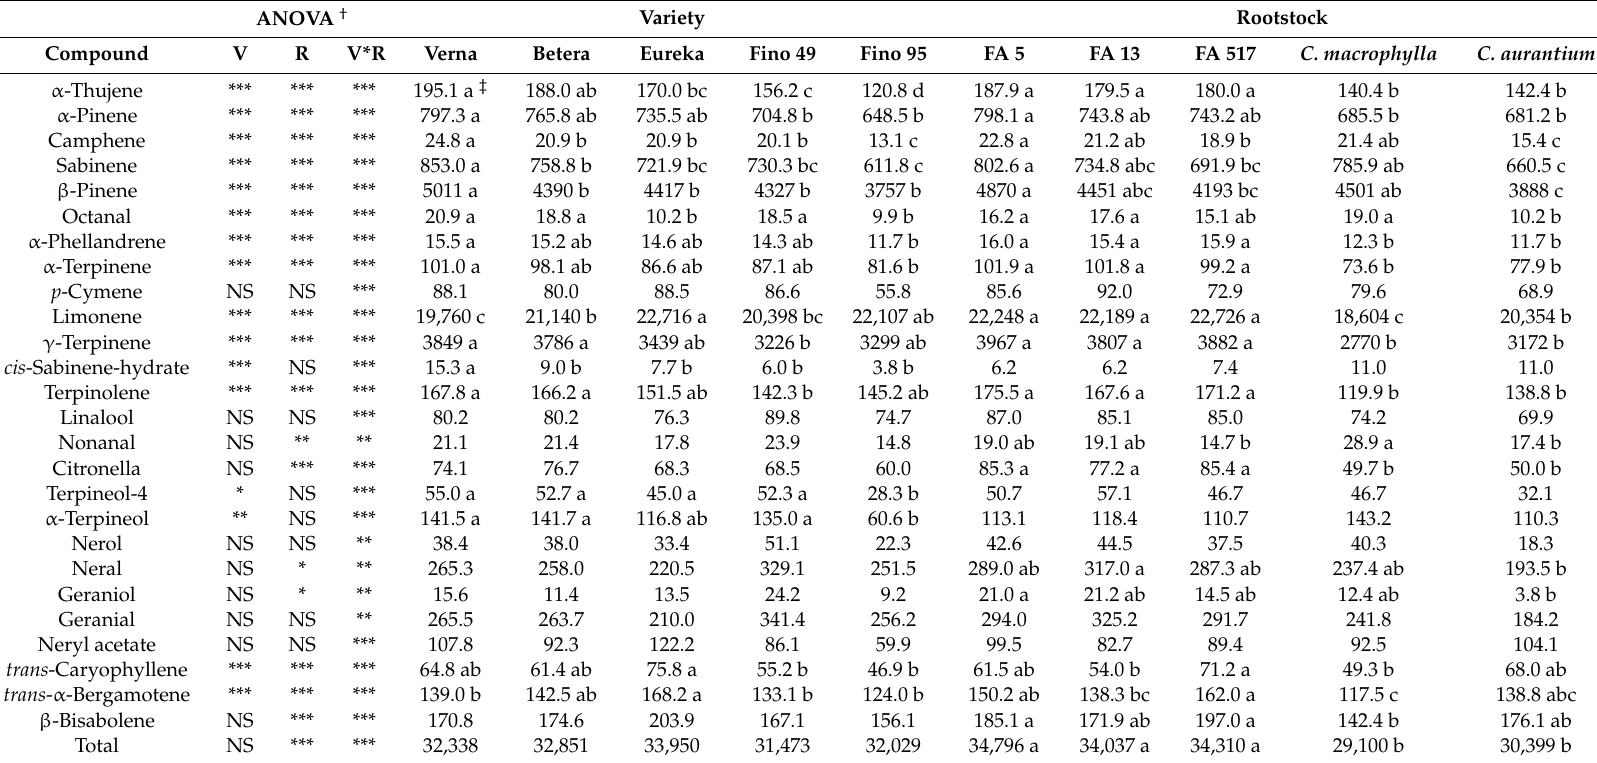
Table 2. Concentrations (mg · kg − 1 ) of volatile compounds in lemon peel